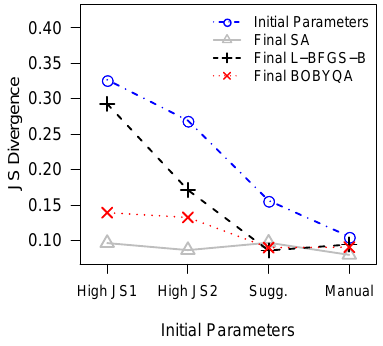
Figure 8. Convergence comparisons of three different optimisers with three different set of initial DS parameters.